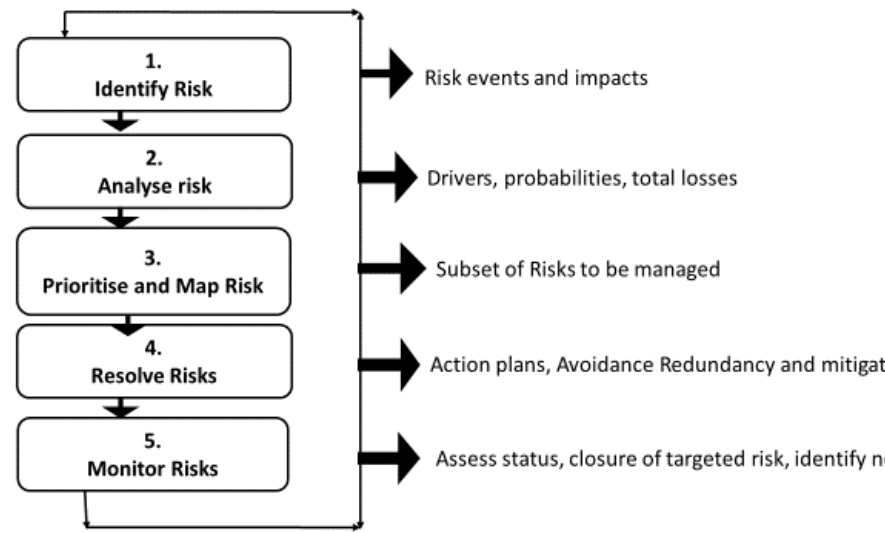
Figure 1. Risk Management Process by Smith and Merritt (2002).